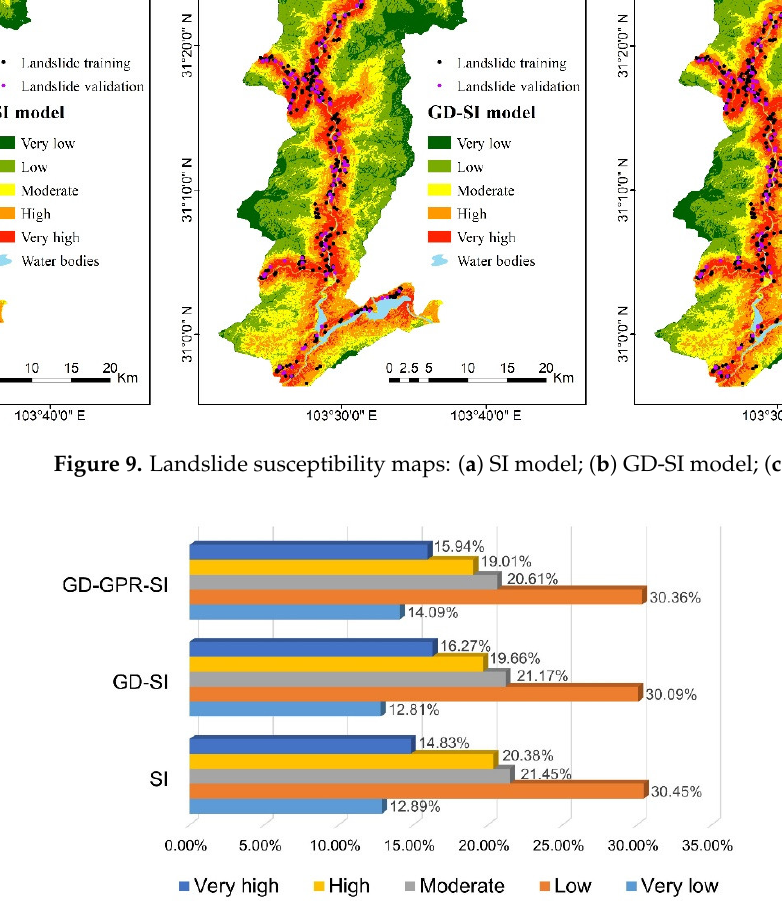
Figure 10. Area percentage of different susceptibility classes.